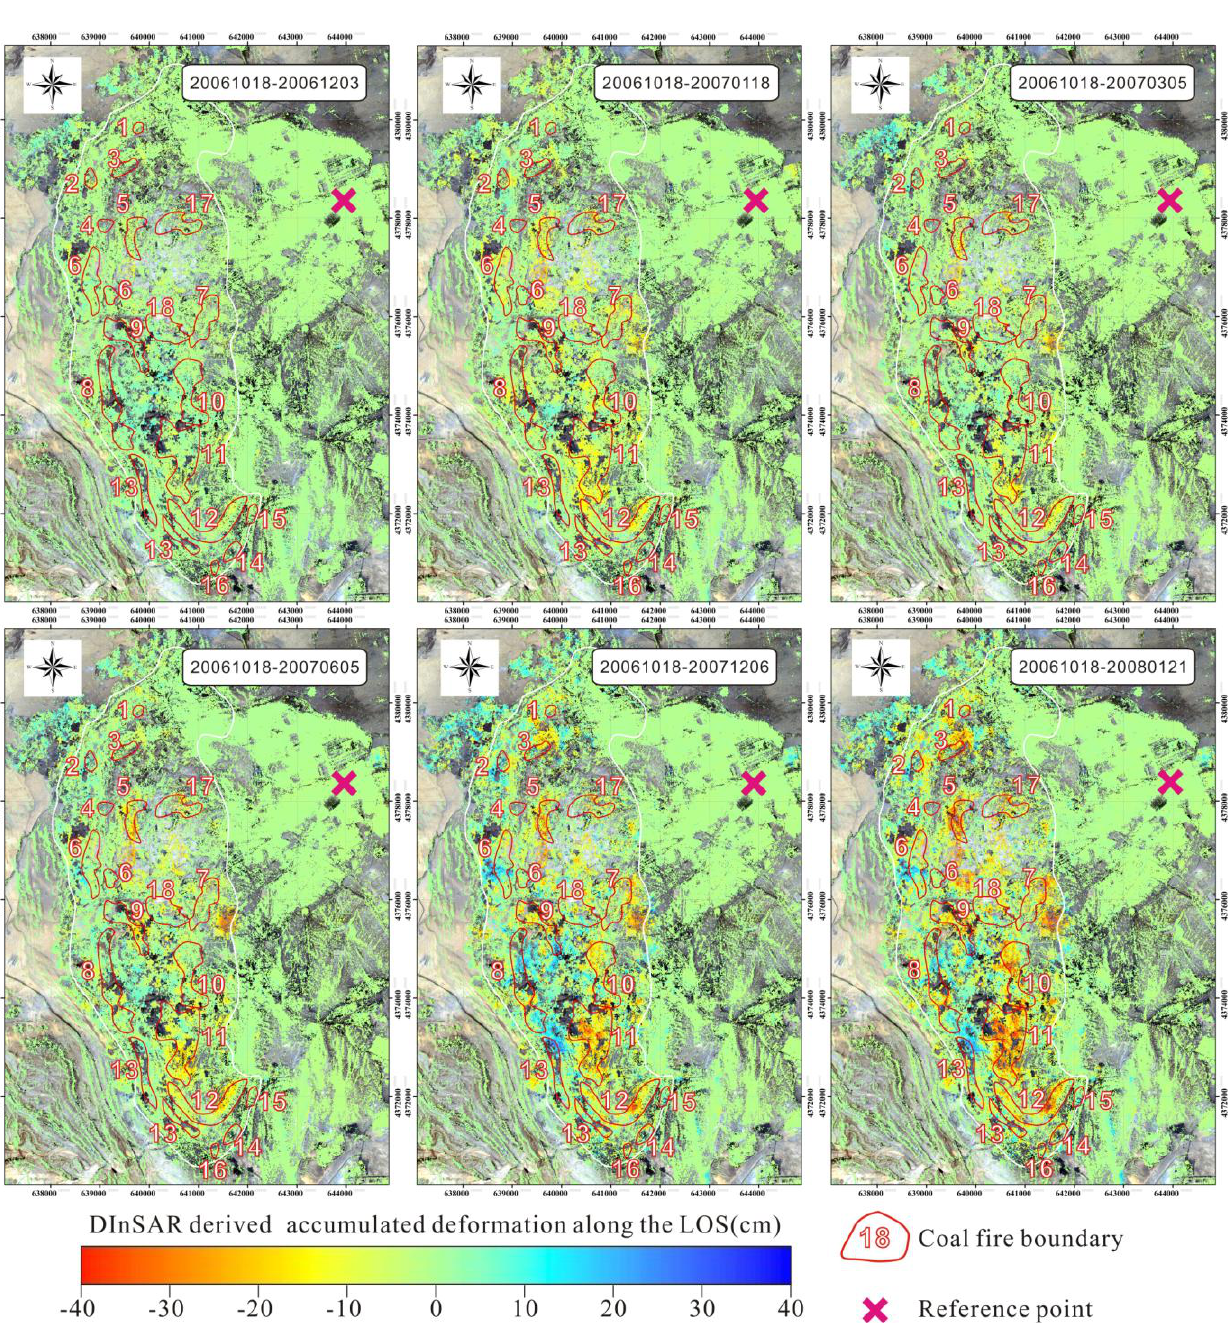
Figure 8. DInSAR derived subsidence time series in Wuda coalfield with respect to 18 October 2006 for 6 dates; 3 December 2006, 18 January 2007, 5 March 2007, 5 June 2007, 6 December 2007, and 21 January 2008. The colour tones from light yellow to red correspond to subsiding areas; the tones from dark blue to sky blue indicates slight uplift; the light green correspond to stable areas. This result is superimposed on a Google Earth image and the magenta cross represents the location of the reference point, which is loated in Wuda urban area. The red polygons illustrate the coal fire boundaries mapped in the field survey in